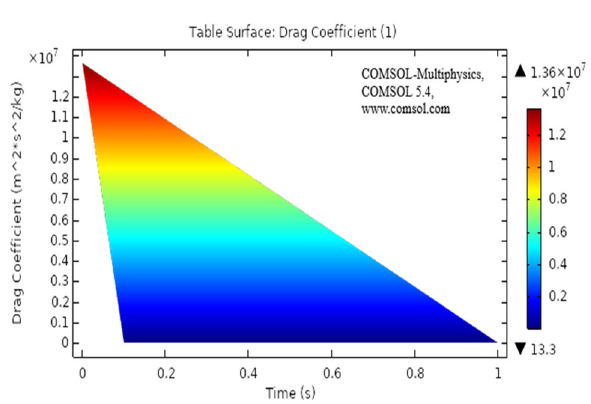
Figure 14. Surface table of drag coefficient for laminar